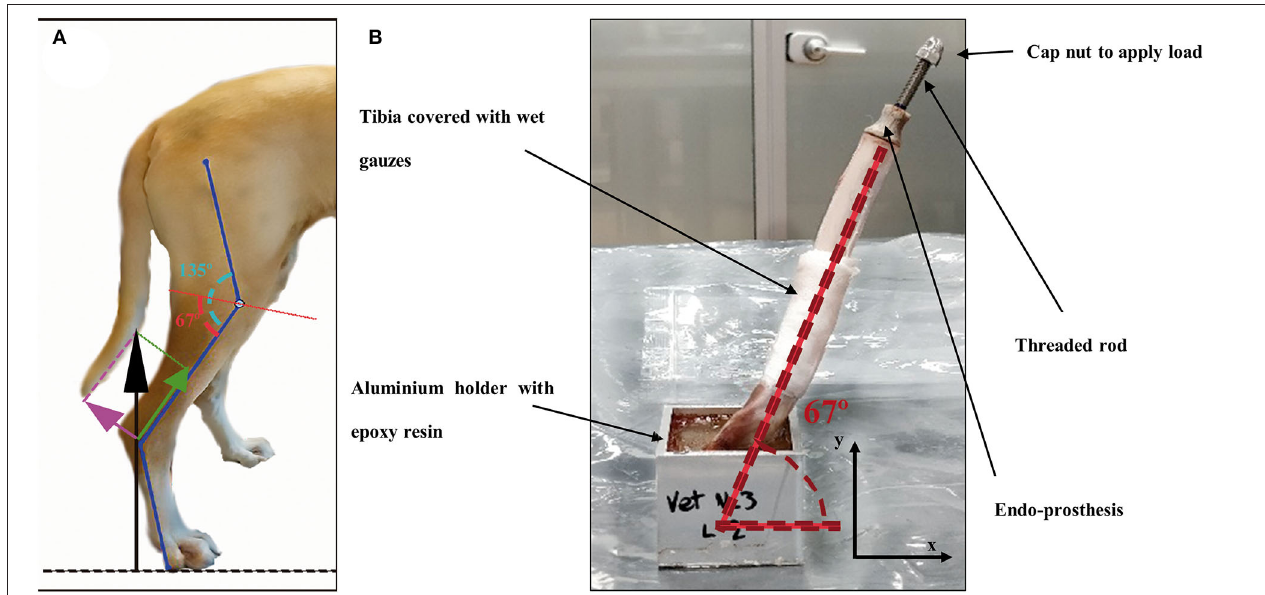
FIGURE 4 | (A) Schematic figure of the decompounded ground reaction force (black arrow) on the canine tibia in compression (green arrow) and bending forces (pink arrow). Angle of the stifle joint (135 ◦ ) was split in half by a red line as a reference for testing. (B) Endoprosthesis-tibia construct at 67 ◦ to the testing table for compression-bending and fatigue testing.